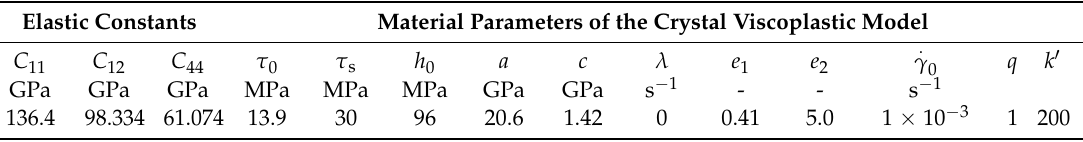
Table 5. Elastic constants and crystal plasticity parameters of the pure copper T2 [53]. Elastic